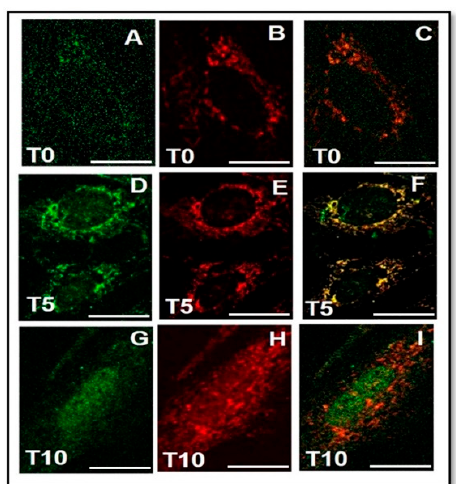
Figure 8. Immunofluorescence of Fetuin-A ( A , D , G ), FGF23 ( B , E , H ) and MERGE ( C , F , I ), respectively, at T0, T5, and T10 in M2-10B4. Scale bar = 20 µ m.